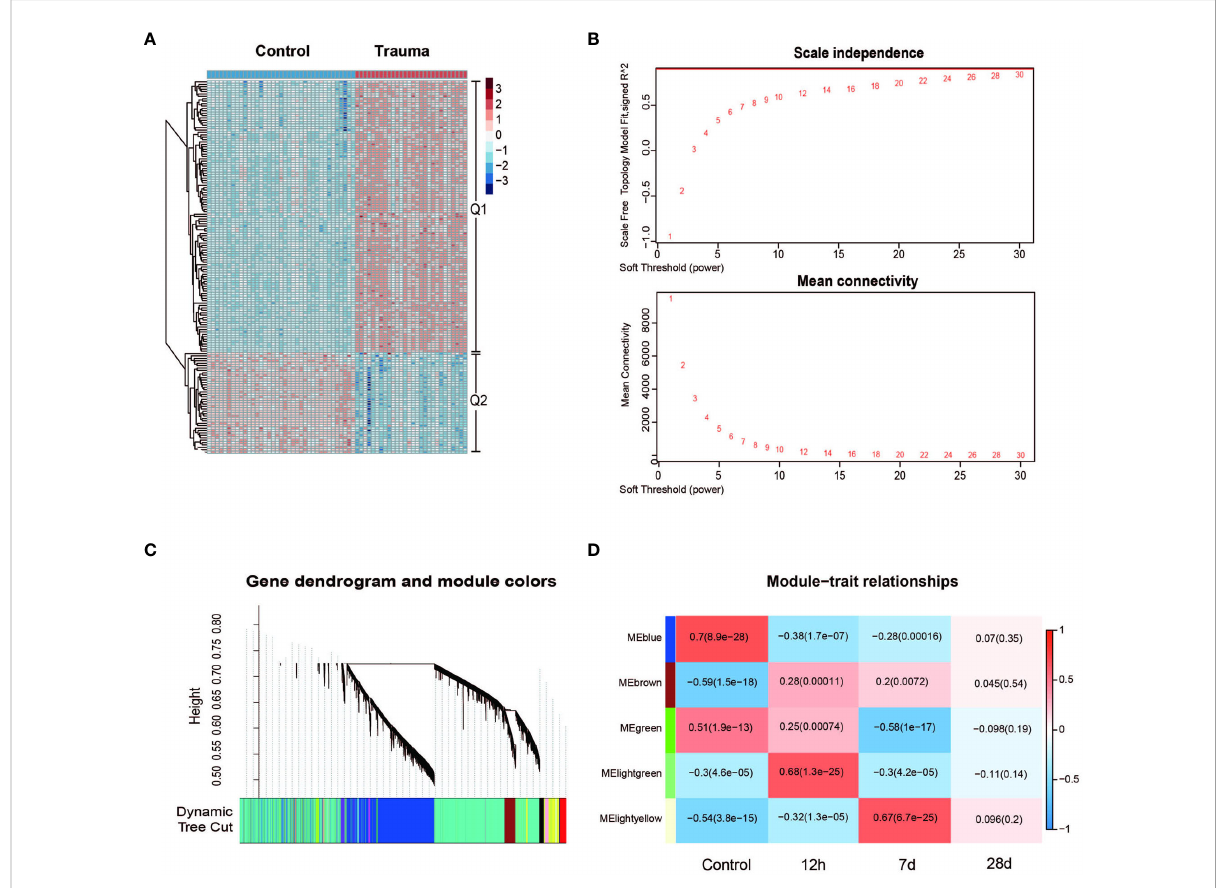
FIGURE 1 Gene network analysis of trauma patients. (A) Heatmap of processed differentially expressed genes (DEGs) expression pro fi les in trauma patients and control participants. (B) Scale independence and mean connectivity under the different soft threshold values. (C) Gene co-expression modules, represented by different colors under the gene cluster tree. Each color represents a different co-expression module. (D) Heatmap of the correlations between module and the injury time of trauma patients (control, injury after 12 hours, injury after 7 days and injury after 28 days). Five modules that were randomly assigned color labels were identi fi ed (blue, brown, green, light green and light yellow). The color of the square area represents the MS (module signi fi cance). When the MS value approaches +1, there is a positive correlation between the module and trait; otherwise, when the MS value approaches – 1, there is a negative correlation between the module and trait. The p -values are shown in parentheses and were calculated using the Student ’ s t